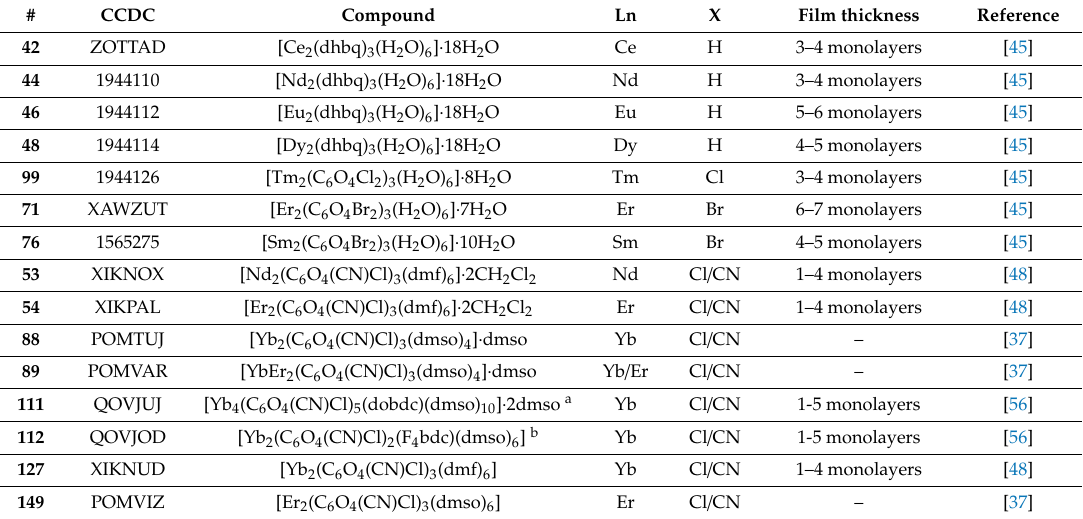
Table 32. Ln-anilato compounds prepared as thin